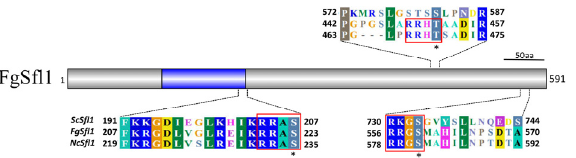
Figure 6. Site-directed mutagenesis of putative PKA phosphorylation sites in FgSfl1. Schematic drawing of the FgSfl1 protein and alignment of the marked region with its orthologs from Neurospora crassa (Nc) and Saccharomyces cerevisiae (Sc). The consensus PKA phosphorylation sites are enclosed with red lines. The putative PKA phosphorylation residues are marked with stars.